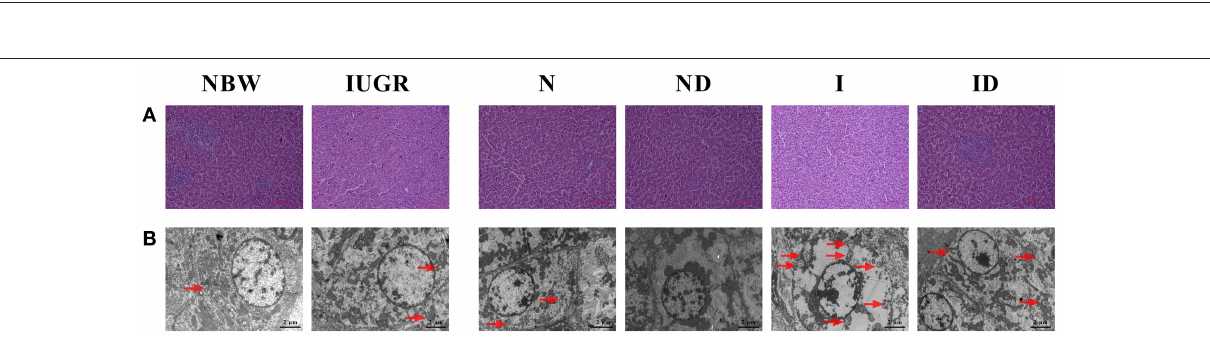
Frontiers in Veterinary Science |